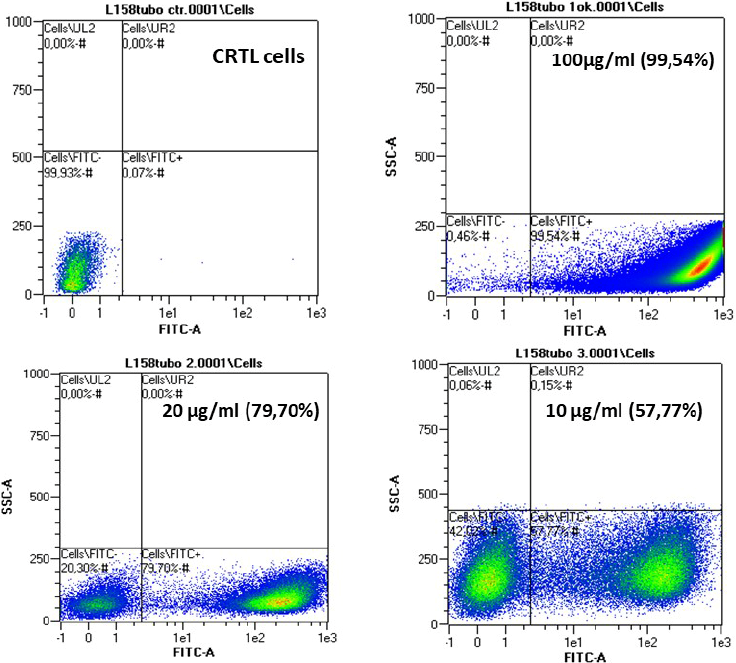
Figure 9. Fluorescence-activated cell sorting of C8166 treated with 0, 100, 20 and 10 µg/ml of FITC- CS/hsDNA particles for 4 h of incubation at RT (CS MW = 50 KDa, N/P = 10).